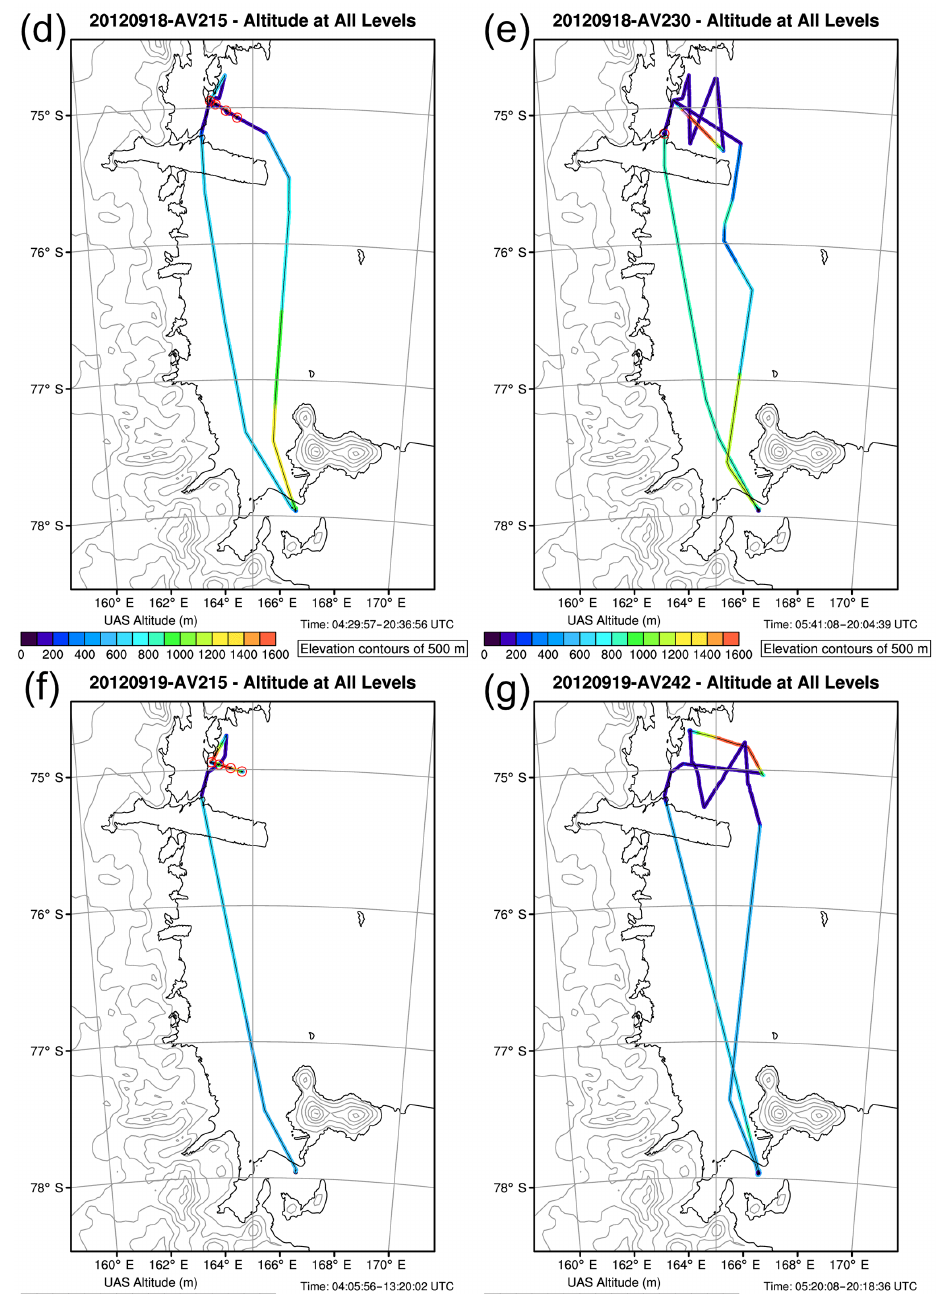
www.earth-syst-sci-data.net/8/115/2016/ Earth Syst. Sci. Data, 8, 115–126,